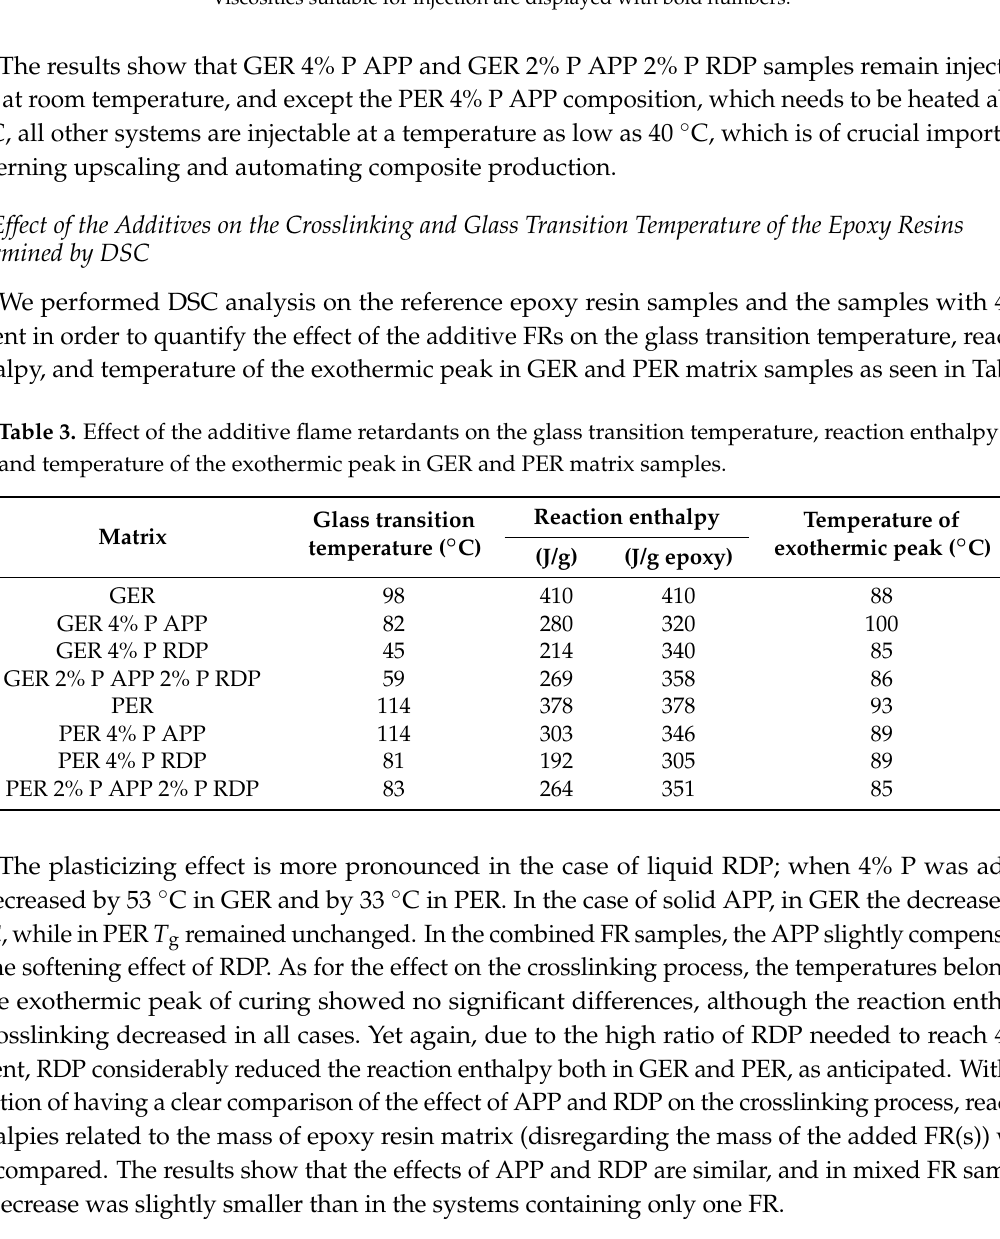
* Viscosities suitable for injection are displayed with bold numbers.